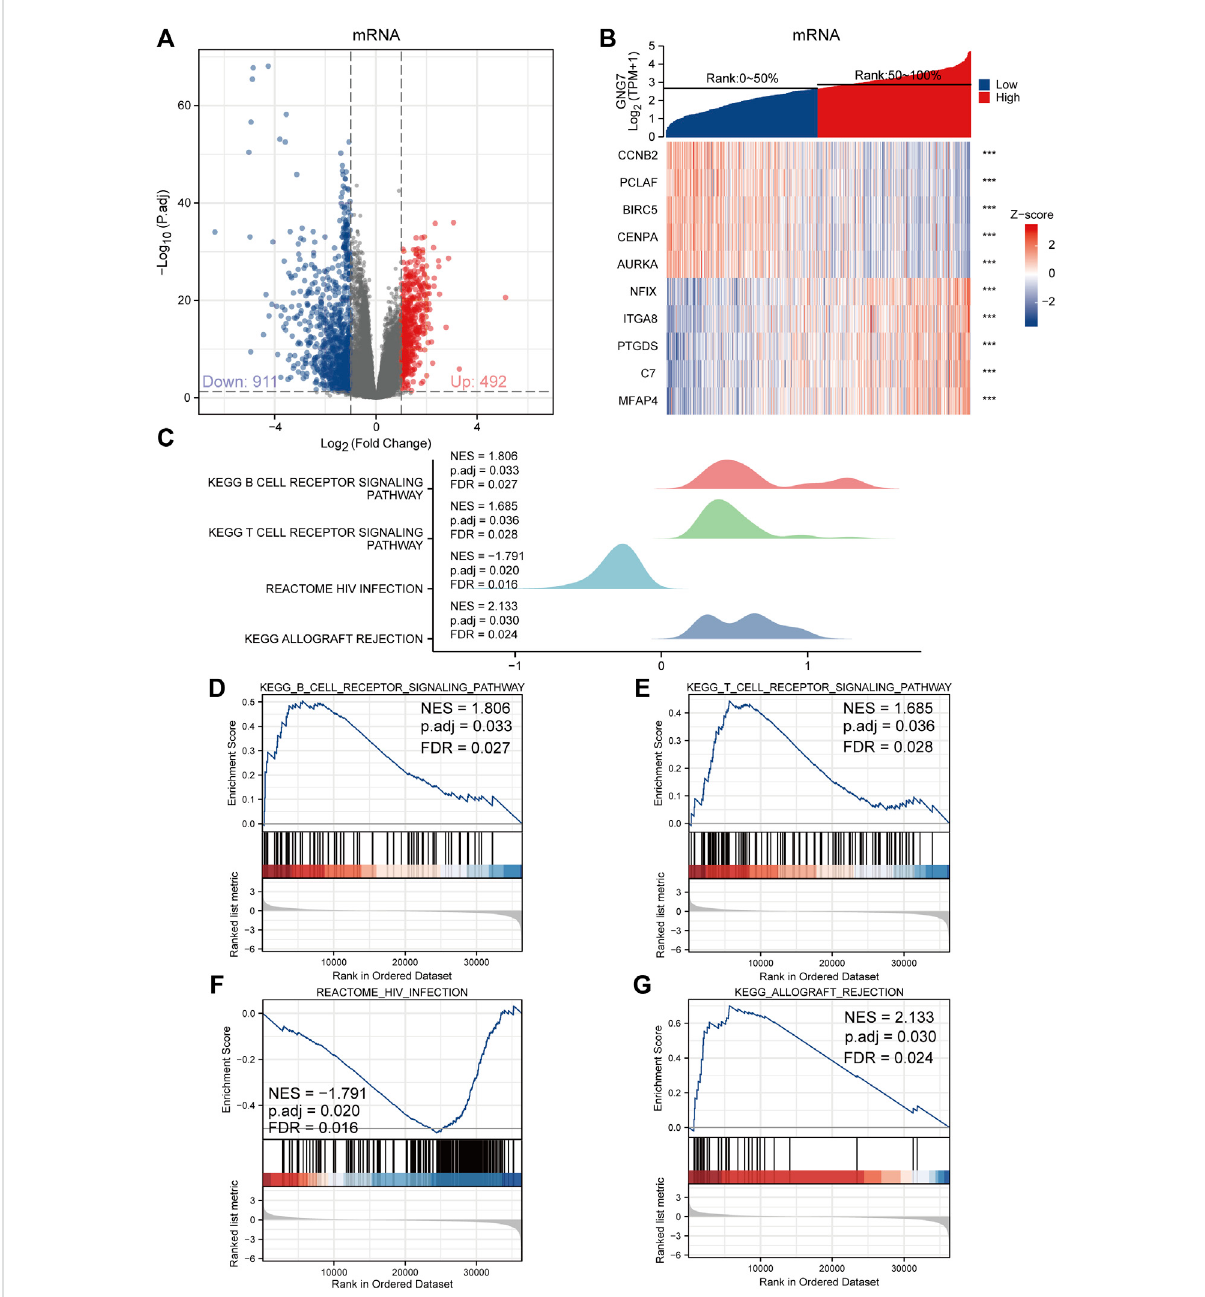
FIGURE 5 Functional annotation of differentially expressed genes (DEGs) regulated by GNG7 in LUAD. (A,B) Based on the median GNG7 expression level, LUAD patientsfrom theTCGA-LUAD datasetwerestrati fi edinto GNG7-highand GNG7-lowgroups.Expression pro fi les ofmRNAs intwogroups are presented by volcano plots (A) and heatmaps (B) . (C) Pathway enrichment plots from GSEA. (D – G) The B cell receptor signaling pathway (D) , T cell receptor signaling pathway (E) , HIV infection (F) , and allograft rejection (G) were positively correlated to GNG7 expression. TCGA, the cancer genome atlas; LUAD, lung adenocarcinoma; NES, normalized enrichment score; FDR, false discovery